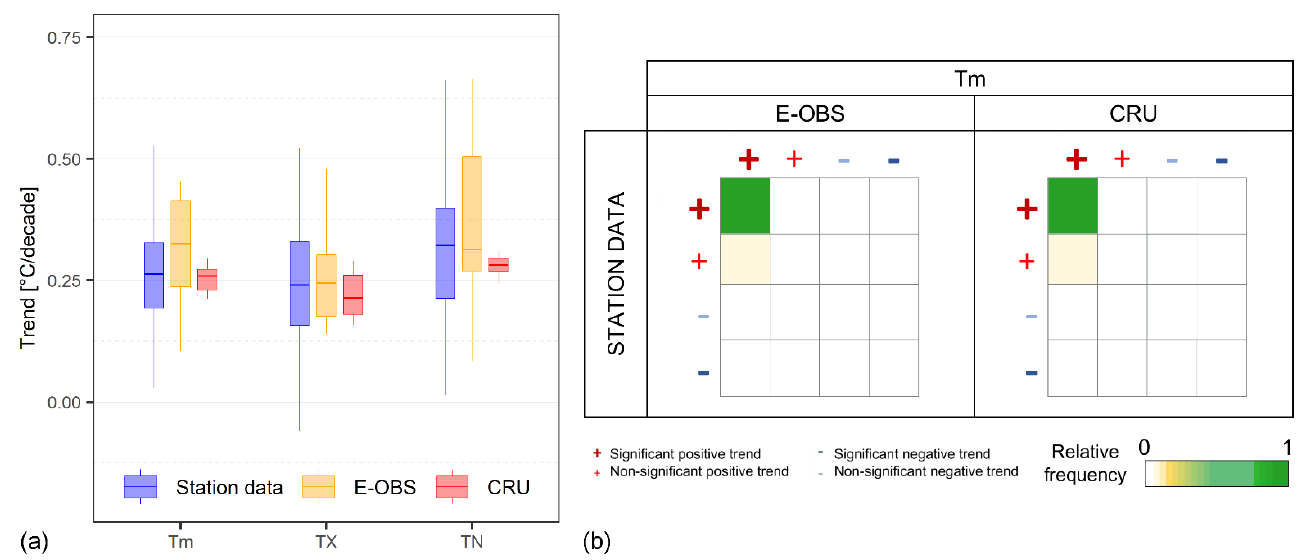
Figure 4. Results of trend analysis for annual mean, maximum and minimum temperatures (Tm, TX and TN) using the three considered databases: ( a ) calculated trend rates; and ( b ) normalized contingency matrices for detected trend signs.